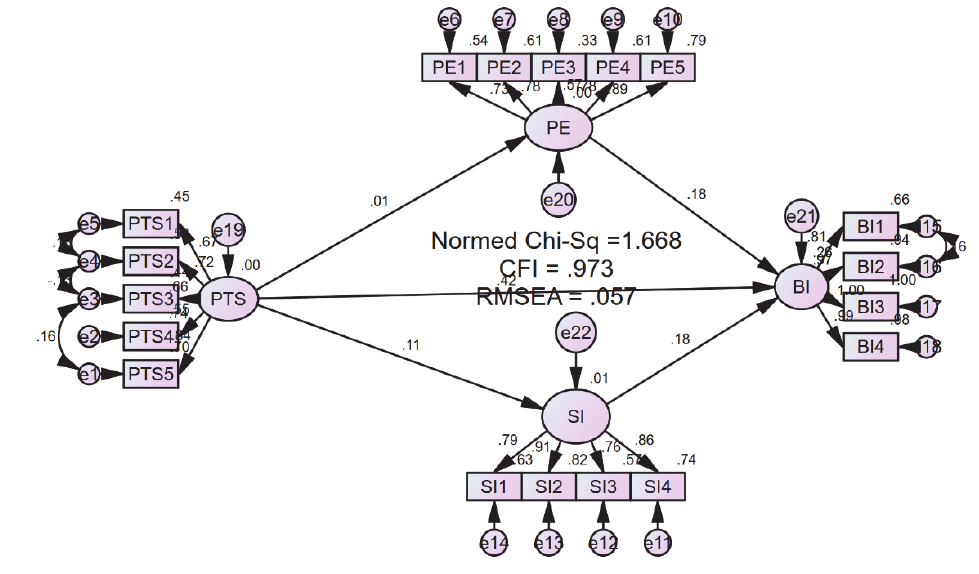
Fig. 5. SEM analysis framework